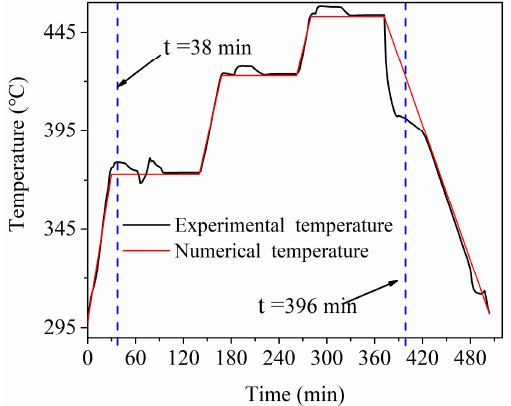
Figure 12. The air temperature of simulation and experiment.